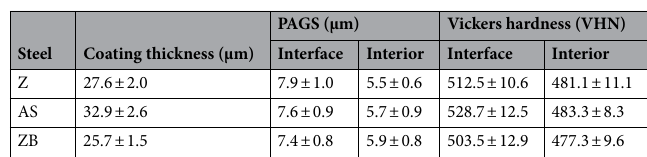
Table 1. Coating thickness, prior austenite grain size (PAGS), and Vickers hardness of the Z, AS, and ZB steels.